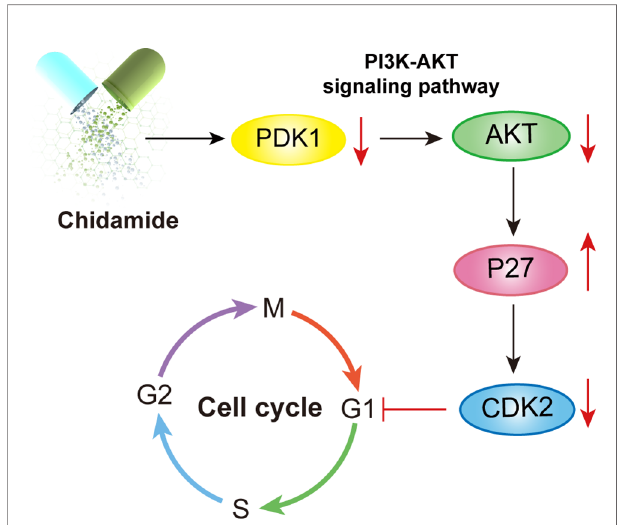
FIGURE 9 | Illustration of the mechanism underlying chidamide induced follicular lymphoma growth inhibition. Chidamide exerts antitumor activity toward FL both in vitro and in vivo , potentially by targeting the PDK1-Akt- P27-CDK2 pathway and triggering caspase dependent apoptosis, fi nally markedly blocking cells in the G0/G1